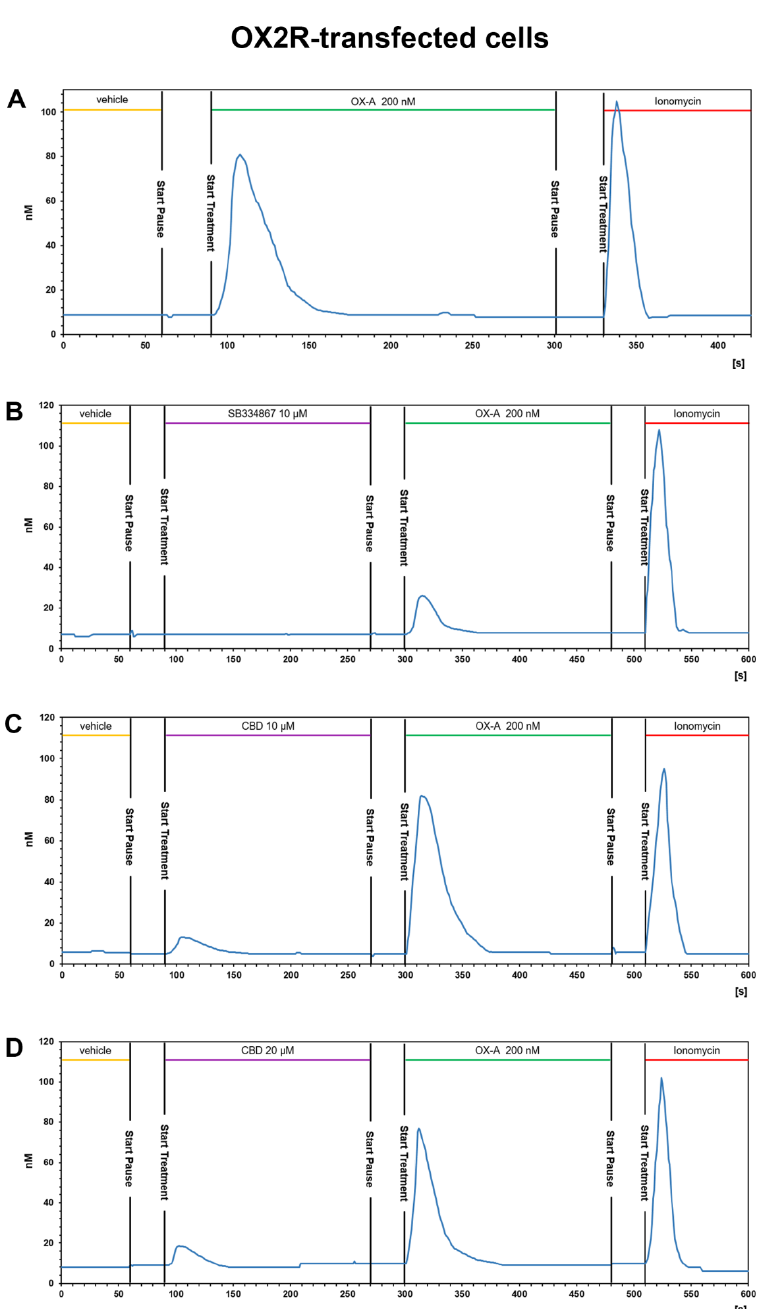
Figure 5. CBD does not alter the OX-A-induced [Ca 2+ ] i increase in CHO cells stably transfected with OX2R. Representative traces of single-cell [Ca 2+ ] i response in Fura-2- loaded CHO cells stably overexpressing OX2R and treated with 200 nM OXA, alone or in combination with 10 µ M SB334867